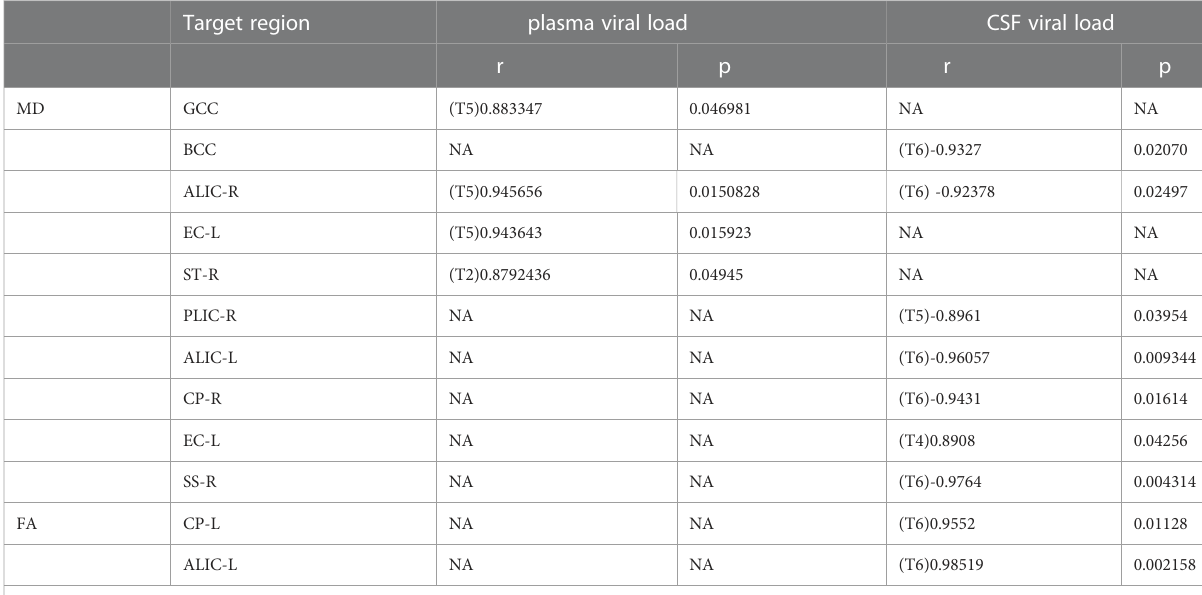
TABLE 4 The correlations between DTI metrics and viral load without